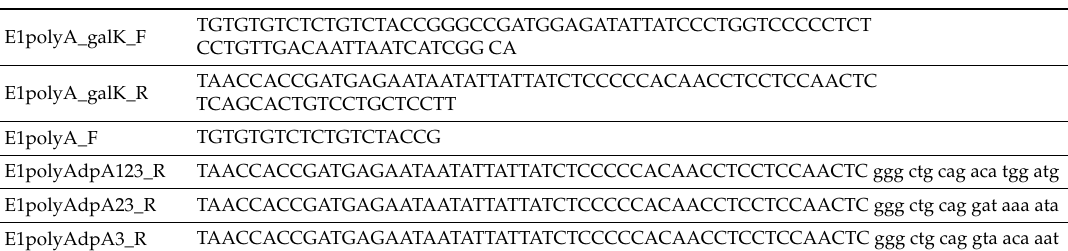
Table 2. Primers for bacterial artificial chromosome (BAC) mutagenesis to generate the mutations of